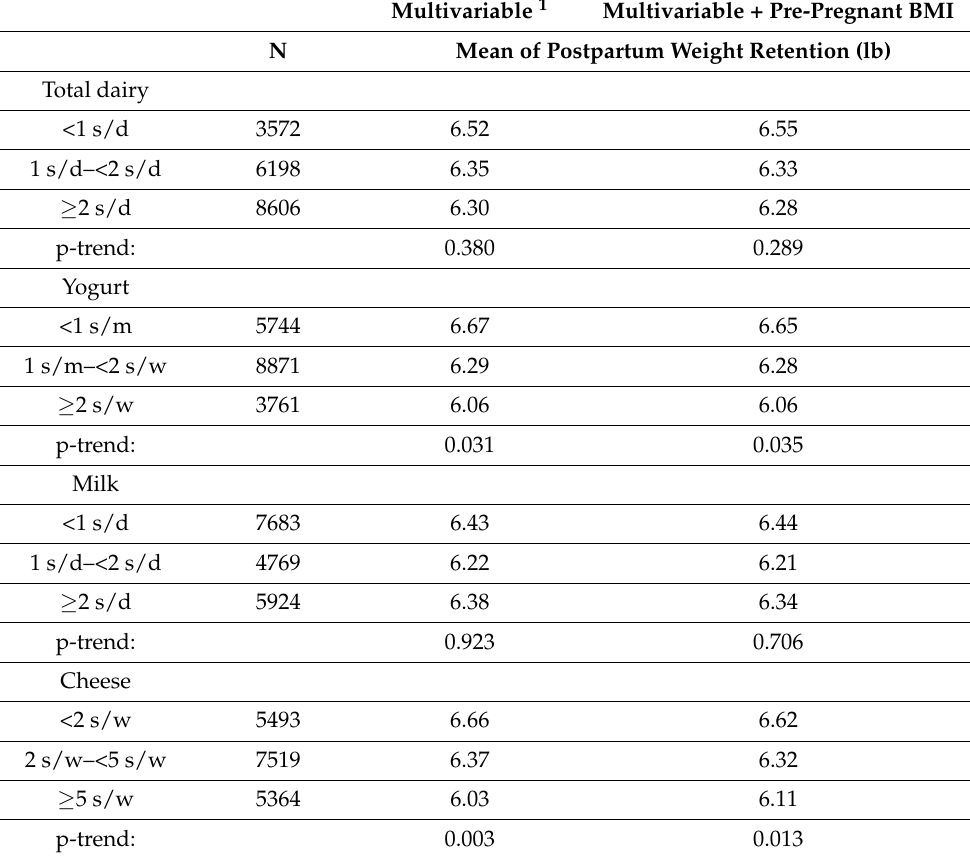
Table 2. Postpartum Weight Retention by Intakes of Different Dairy